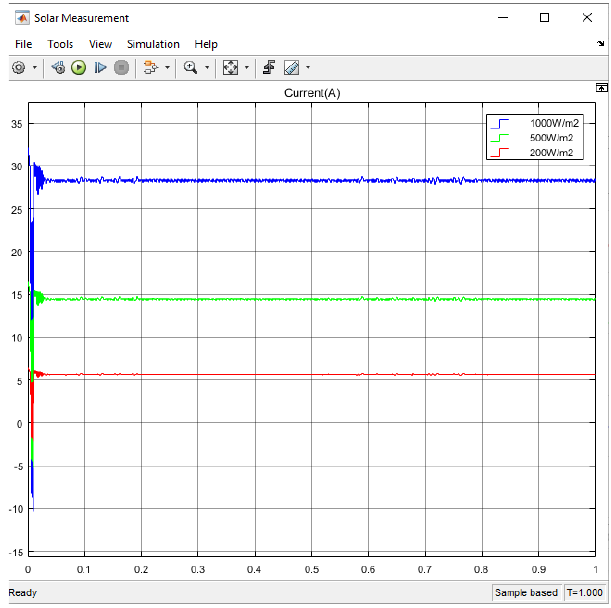
Figure 19. OSSC performance using FLC.